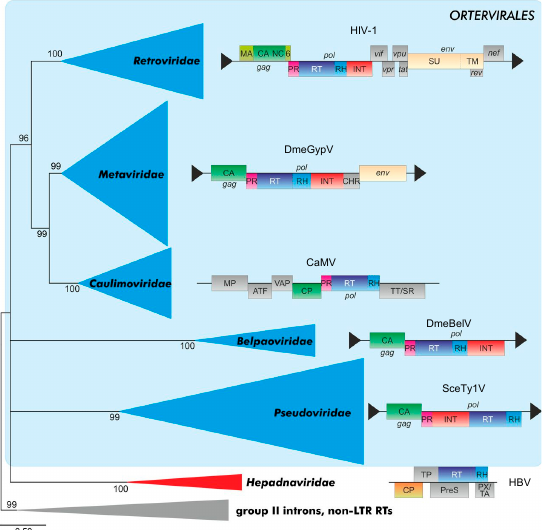
Figure 6. Maximum-likelihood phylogeny of viral reverse transcriptases. The tree includes sequences of 290 viruses belonging to all International Committee on Taxonomy of Viruses (ICTV)-recognized genera of reverse-transcribing viruses. The phylogeny was inferred using PhyML [115] with the LG + G + F substitution model and is rooted with sequences from nonviral retroelements (bacterial group II introns and eukaryotic LINE retroelements). Genomic organizations of selected representatives of reverse-transcribing viruses are shown next to the corresponding branches. Long terminal repeats are shown as black triangles. Note that members of the virus families display considerable variation in gene/domain content [116], which is not captured in this figure. Abbreviations: 6, 6-kDa protein; ATF, aphid transmission factor; CA/CP, capsid protein; CHR, chromodomain (present only in the integrase of particular clades of metaviruses of plants, fungi, and several vertebrates); gag, group-specific antigen; env, envelope genes; INT, integrase; LTR, long terminal repeat; MA, matrix protein; MP, movement protein; NC, nucleocapsid; nef, tat, rev, vif, vpr, and vpu, genes that express regulatory proteins via spliced mRNAs; P, polymerase; pol, polymerase gene; PR, protease; PreS, pre- surface protein (envelope); PX/TA, protein X/transcription activator; RH, RNase H; RT, reverse transcriptase; SU, surface glycoprotein; TM, transmembrane glycoprotein; TP, terminal protein domain; TT/SR, translation trans- activator/suppressor of RNA interference; VAP, virion-associated protein. HIV-1: Human immunodeficiency virus 1 ; DmeGypV: Drosophila melanogaster gypsy virus ; CaMV: Cauliflower mosaic virus ; DmeBelV: Drosophila melanogaster Bel virus ; SceTy1V: Saccharomyces cerevisiae Ty1 virus ; HBV: Hepatitis B virus . Image and caption adapted from [2].